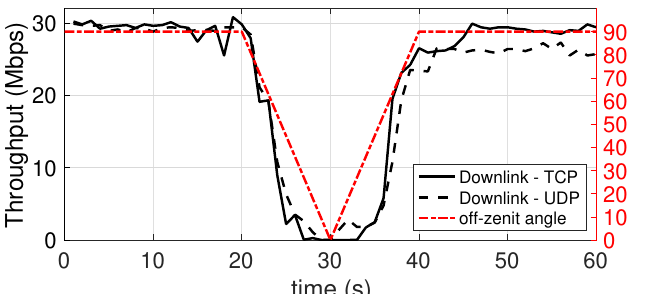
Figure 14. Downlink throughput with different orientation angle of the mobile device. TCP and